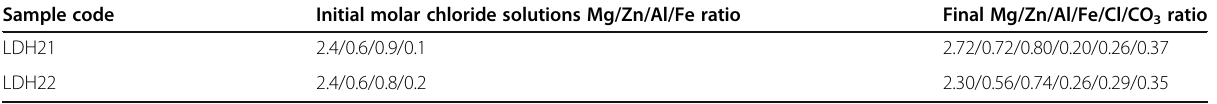
Table 1 Proportion of salts used for the synthesis of LDHs and their codes Sample